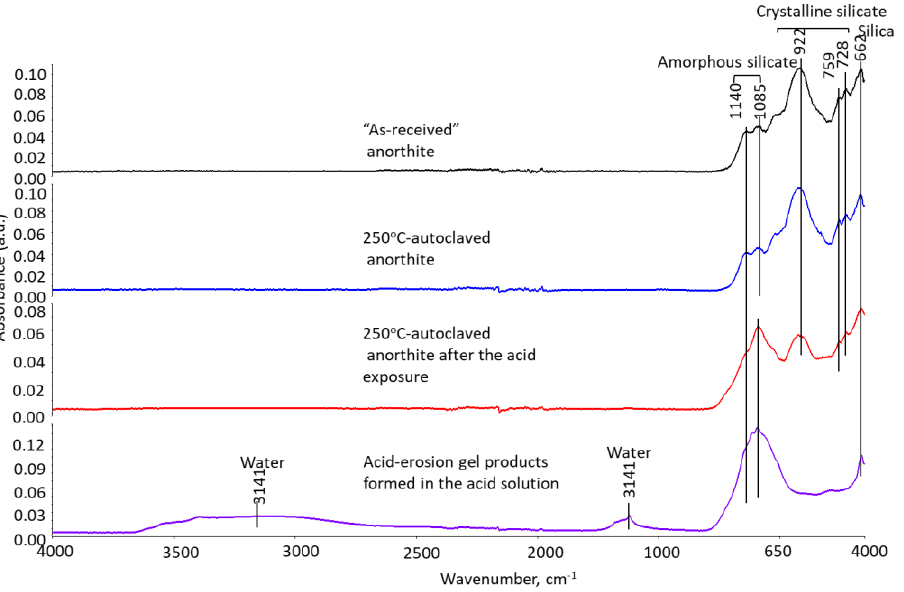
Figure 13. FTIR spectra of anorthite samples from top to bottom: “as received” (before exposure) anorthite, 250 ◦ C-autoclaved anorthite and anorthite exposed to the strong acid. Mullite and aluminum oxide did not undergo any phase changes after 250 ◦ C or acid treatments. The patterns are identical (Figures 12 and